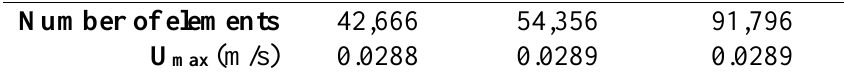
Table 2. Grid independence test for the 15 o